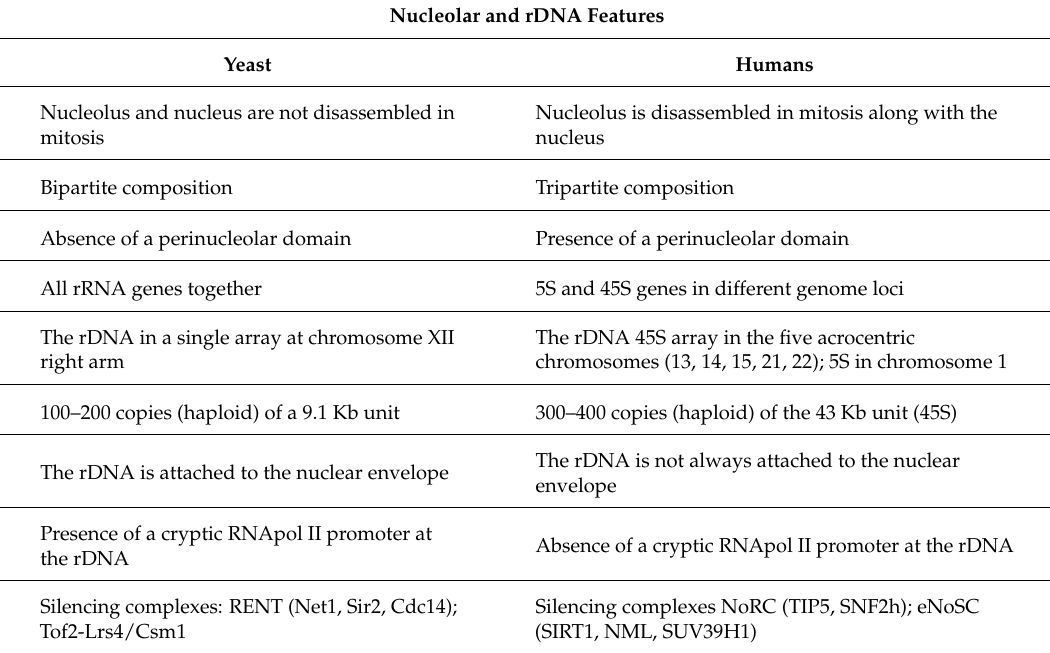
Structural differences between the yeast and human nucleolus and rDNA. RENT: regulator of nucleolar silencing and telophase exit; NoRC: nucleolar remodeling complex; eNoSC: energy-dependent nucleolar silencing